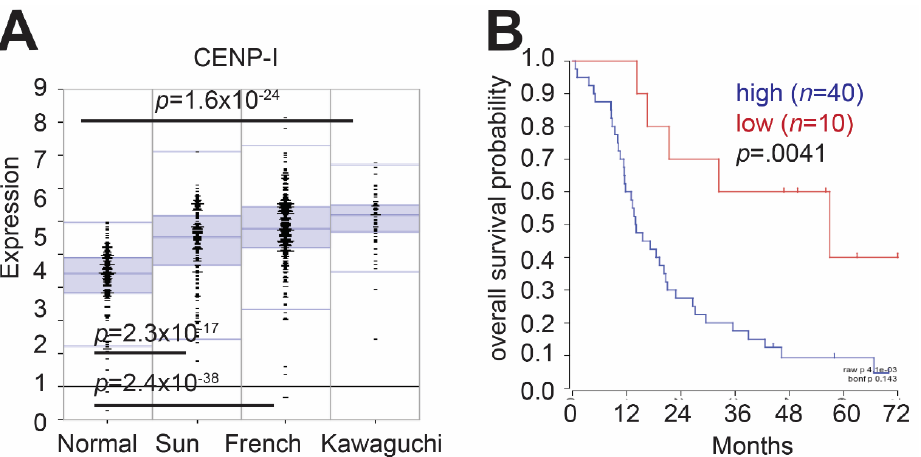
Figure 1. Expression of CENP-I is elevated in glioma patient samples and correlates with poor overall survival. ( A ) CENP-I mRNA levels in normal and tumor datasets. The Sun dataset compared to normal brain has a p value = 2.3 × 10 − 17 , the French dataset compared to normal brain has a p value = 2.4 × 10 − 38 and the Kawaguchi dataset compared to normal brain has a p value = 1.6 × 10 − 24 . ( B ) Overall patient survival comparing high CENP-I expression (blue line) and low CENP-I expression (red line). Data were accessed through the R2 Genomic and visualization platform. Default settings provided by the platform were